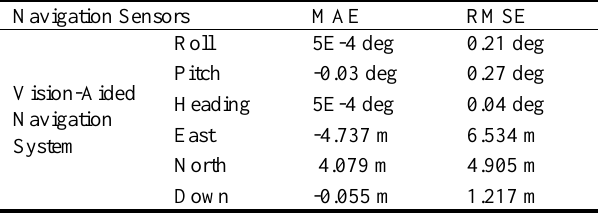
Table 2. The vision-aided navigation system accuracy Navigation Sensors